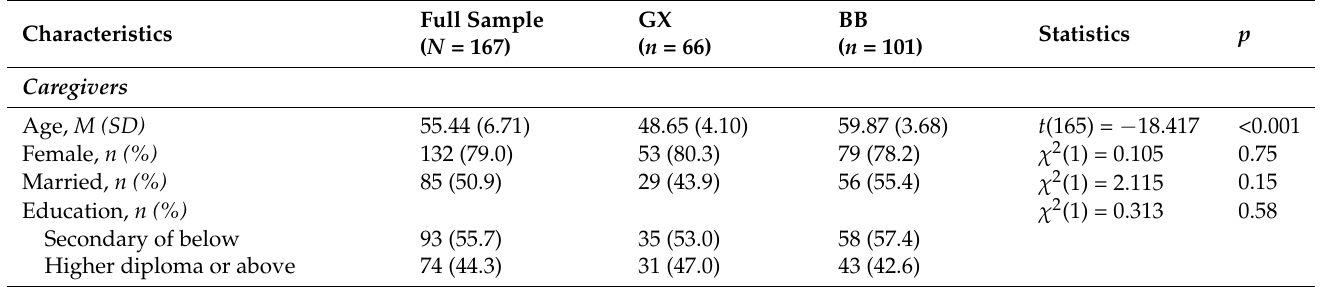
Table 1. Demographic characteristics of caregivers from two generations ( N =